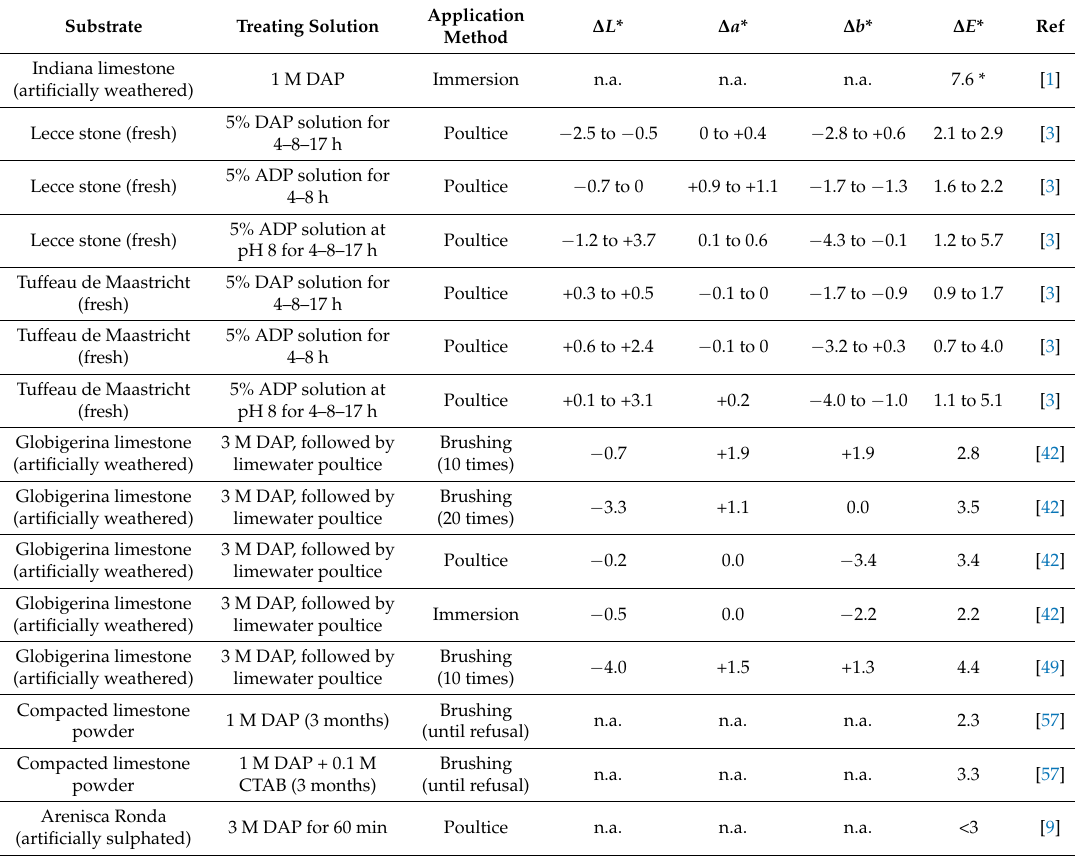
Table 7. Colour change of limestone after the phosphate treatment ( L * = black ÷ white, a * = green ÷ red, b * = blue ÷ yellow, ∆ E * = colour change, n.a. = not available; * in this stone, colour differences up to ∆ E * = 11.5 were measured among different untreated